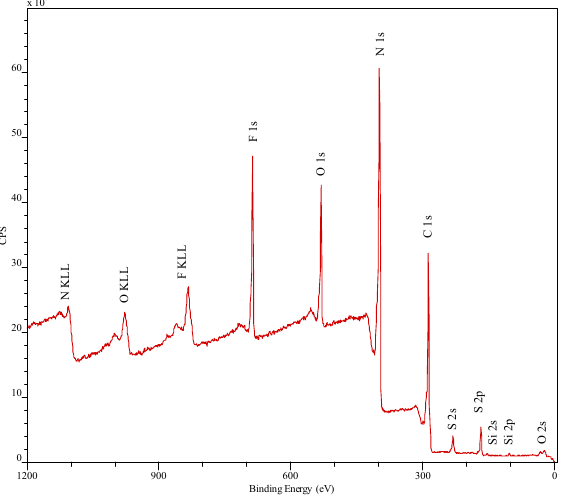
Figure 3. X ‐ ray photoelectron spectroscopy (wide scans) spectrum for F,O,S ‐ codoped g ‐ C 3 N 4 . Figure 3. X-ray photoelectron spectroscopy (wide scans) spectrum for F,O,S-codoped g-C 3 N 4 . Table 1. X-ray photoelectron spectroscopy results, in atomic percentage, for F,O,S-codoped g-C 3 N 4 . Table 1. X ‐ ray photoelectron spectroscopy results, in atomic percentage, for F,O,S ‐ codoped g ‐ C 3 N 4 . C 1s %at. N 1s %at. F 1s %at. O 1s %at. S 2p %at. Si 2p %at. C 1s